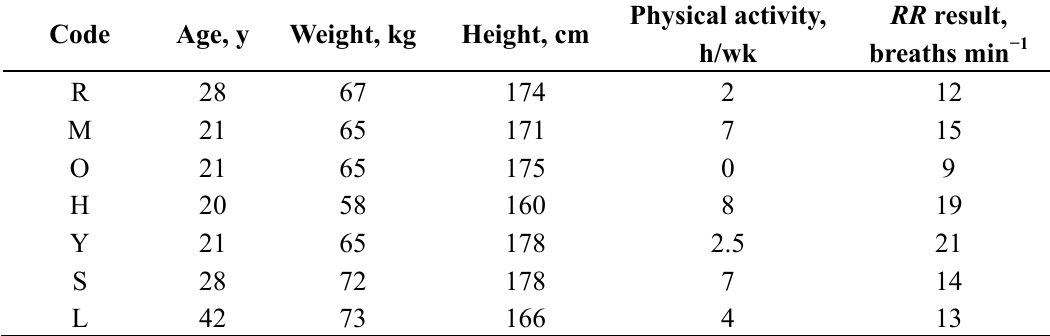
Table 2. Data of participants in the RR assessment